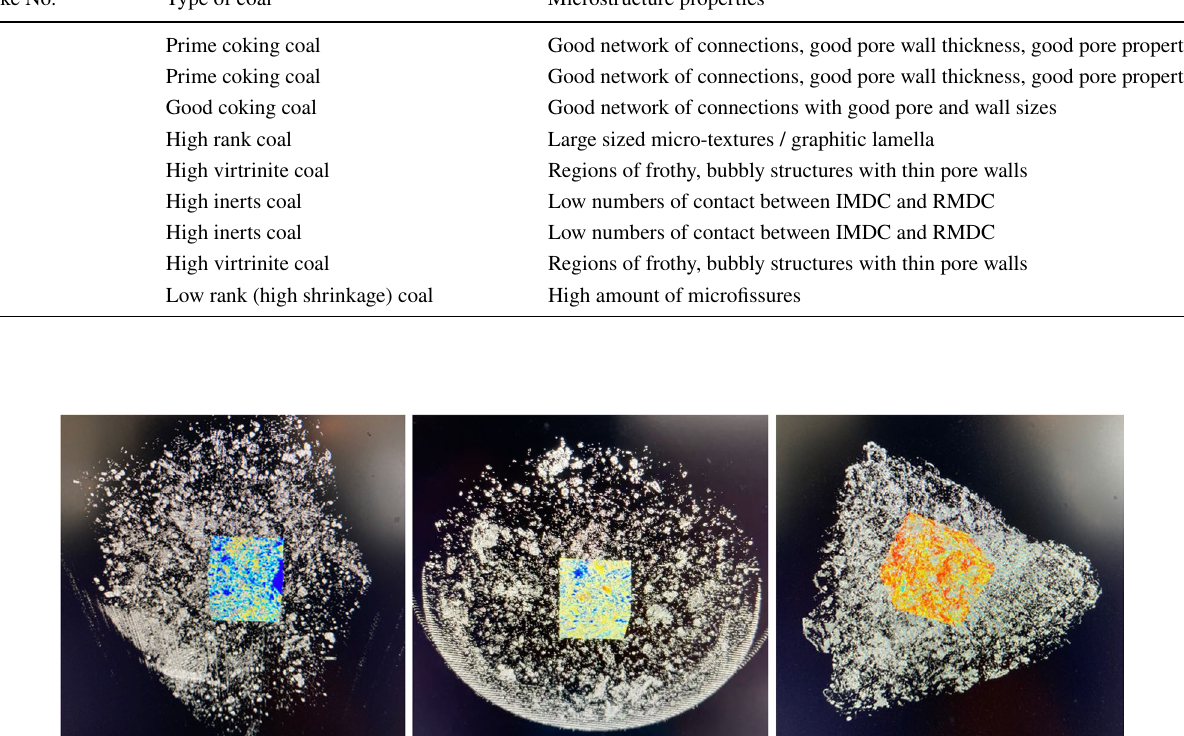
Table 2 Typical microstructure properties and coal ranks for the analyzed cokes Coke No.